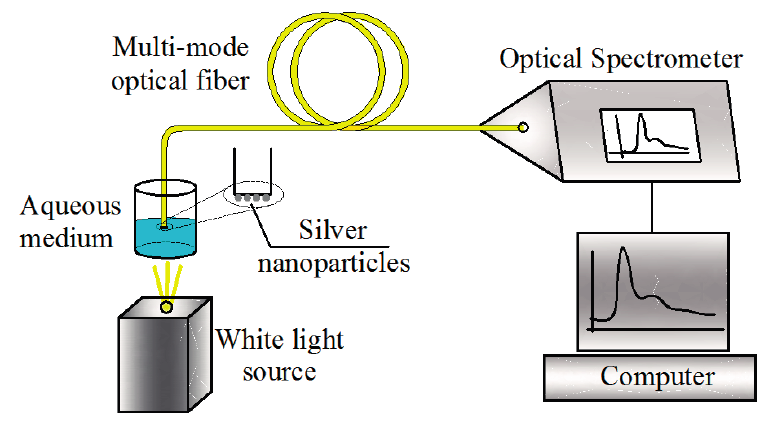
Figure 2. Experimental setup for measuring the refractive index of an aqueous